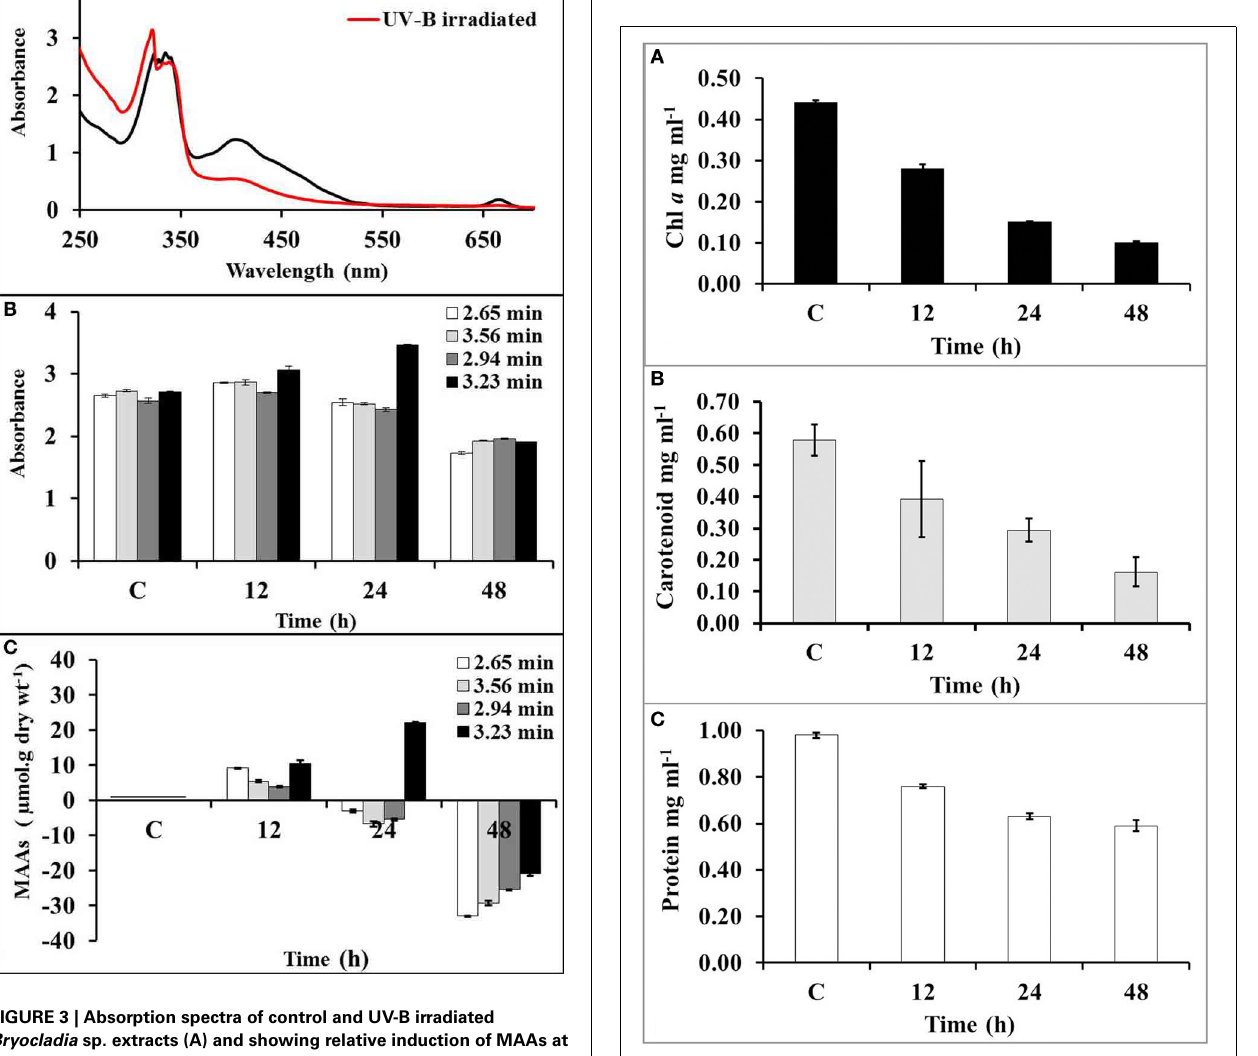
FIGURE 4 | The concentration of chl a (A), carotenoids (B), and total protein (C) after increasing time period of UV-B